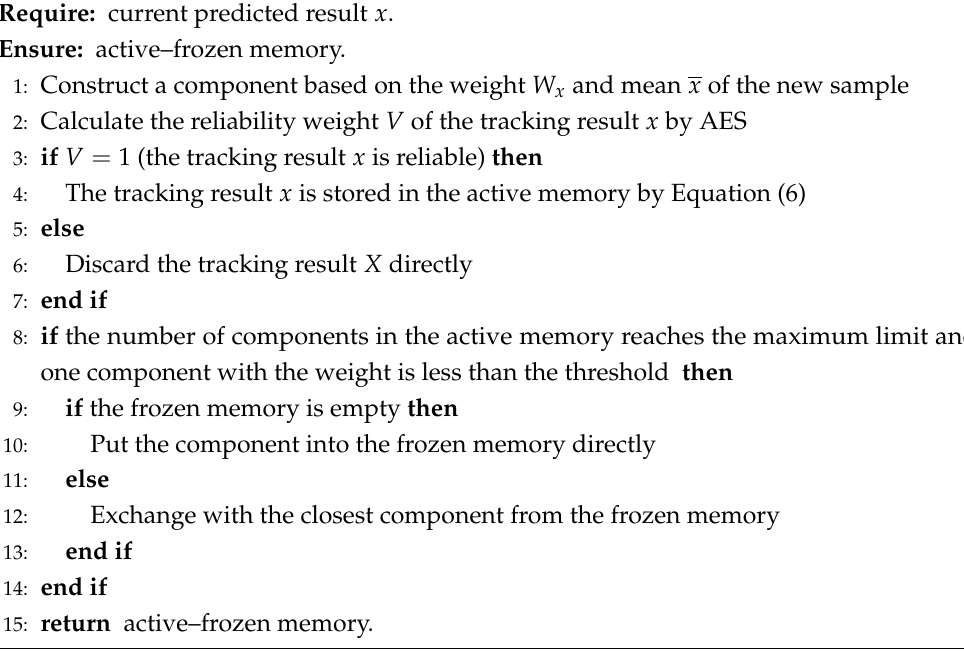
Algorithm 1 Stored procedure of the active–frozen memory